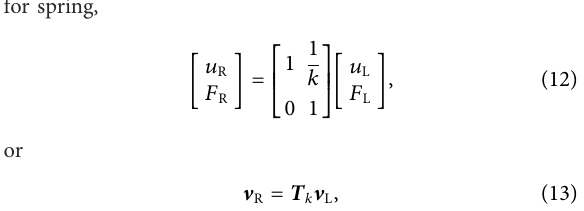
FIGURE 9 Proportion of position where the mass has maximum displacement response in the target band with and without the disorder.